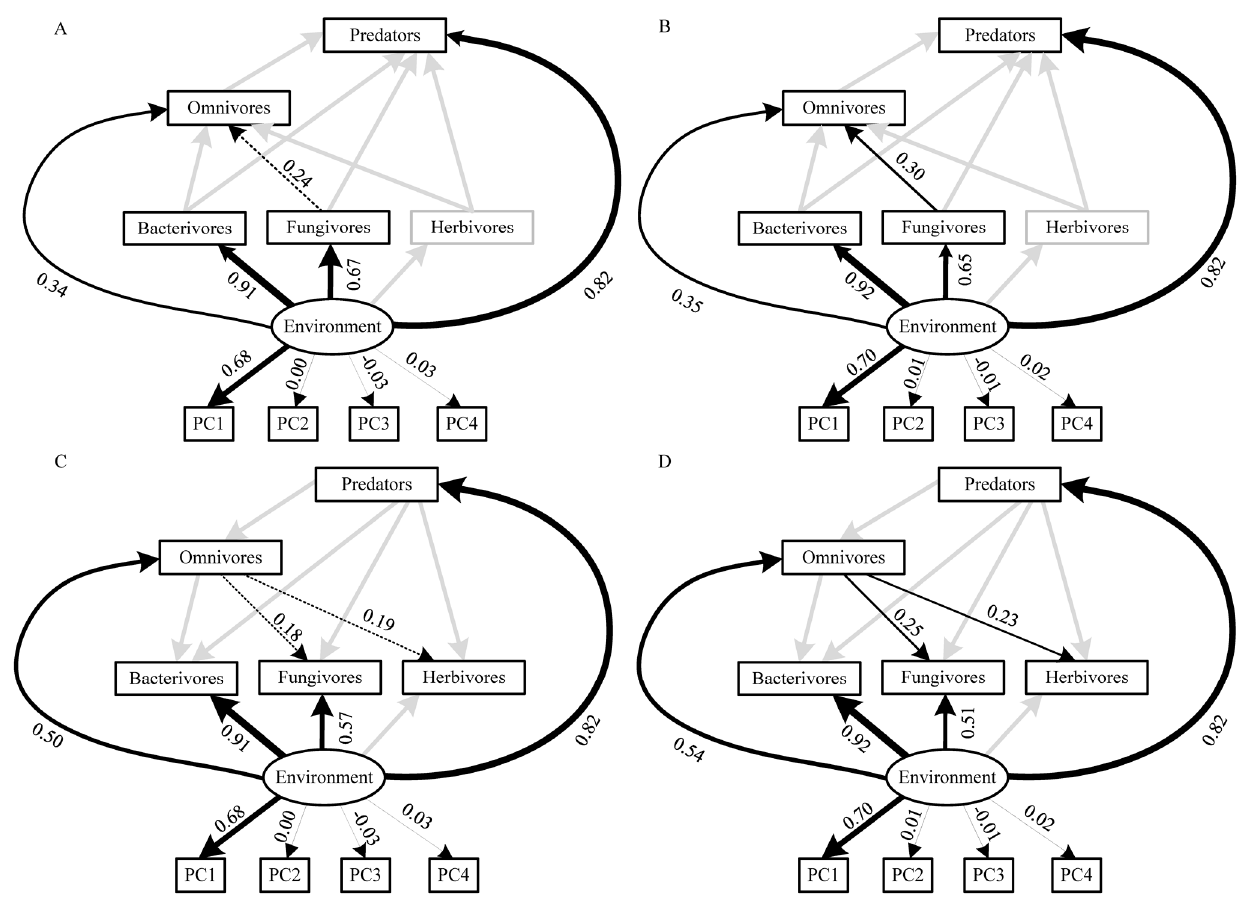
Figure 7. Structural equation modeling (SEM) of environmental variables and trophic group interactions of nematodes in subalpine spruce forests. ( A ) Bottom-up force for daily carbon used in production ( χ 2 = 20.912, df = 19, p = 0.342; GFI = 0.946, p = 0.499; RMSEA = 0.034, p = 0.579); ( B ) Bottom-up force for daily carbon budget ( χ 2 = 22.791, df = 19, p = 0.247; GFI = 0.941, p = 0.497; RMSEA = 0.048, p = 0.474); ( C ) Top-down force for daily carbon used in production ( χ 2 = 30.153, df = 26, p = 0.261; GFI = 0.933, p = 0.539; RMSEA = 0.043, p = 0.532); and ( D ) Top-down force for daily carbon budget ( χ 2 = 32.08, df = 26, p = 0.19; GFI = 0.929, p = 0.537; RMSEA = 0.052, p = 0.442). Numbers on arrows represent standardized path coefficients. The width of the arrow indicates the strength of the causal influence. A black solid arrow represents significant standardized path coefficient ( p < 0.05), and a black dashed arrow indicates non-significant standardized path coefficient ( p > 0.05). Grey arrows indicate paths removed to improve model fit.